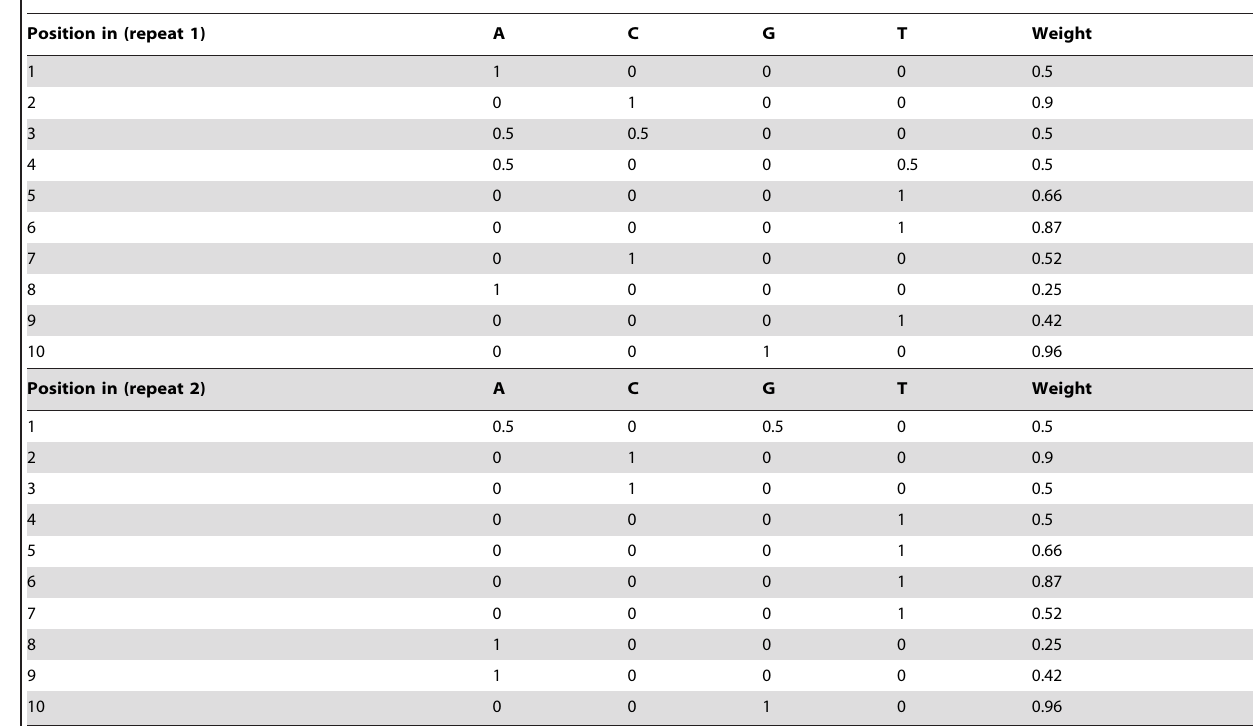
Table 1. The parameters used for the computational predictions.